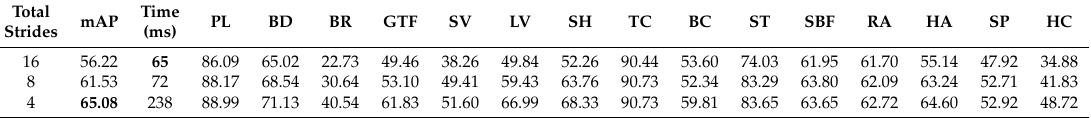
Table 1. The performances of R2CNN with different total stride sizes. Models were trained and validated on the DOTA dataset (%). Computational time were measured on a single V100 GPU with the input size 800 ×